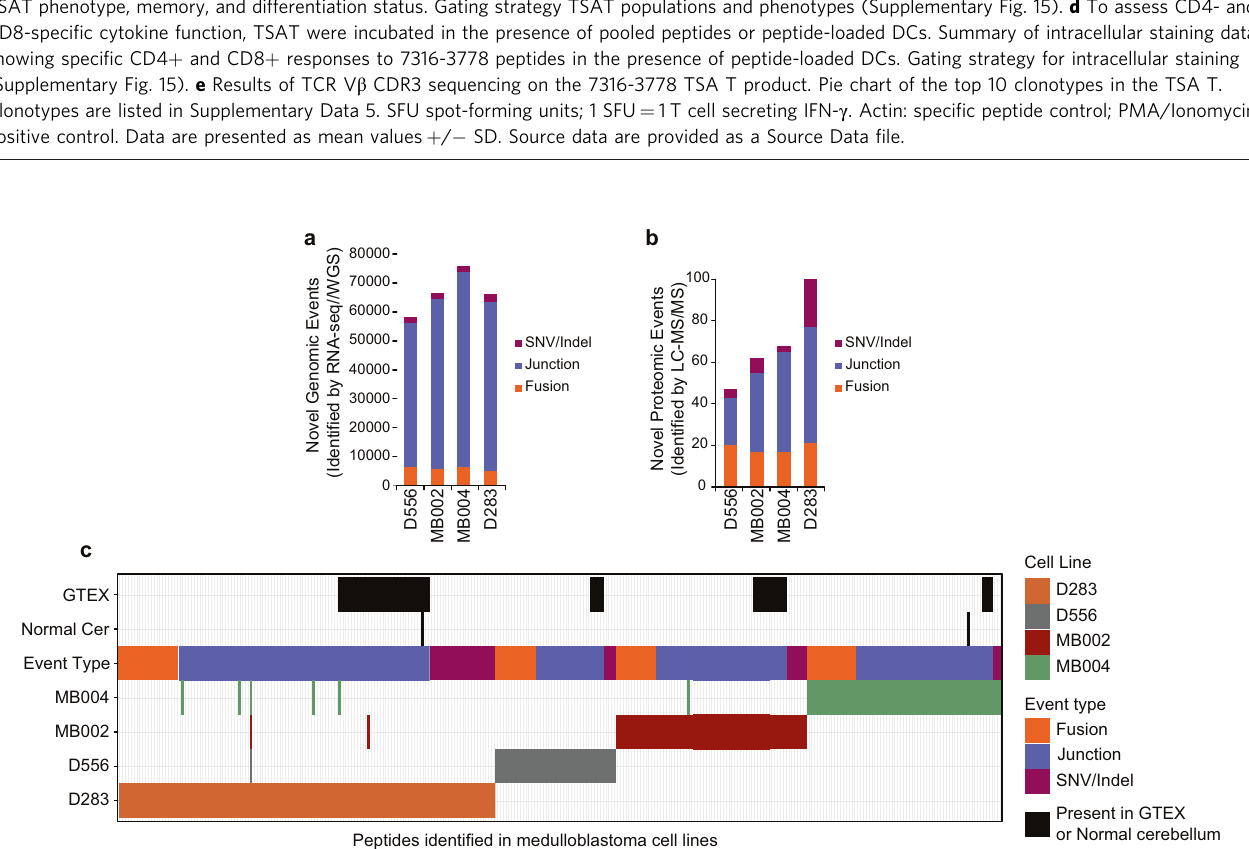
Fig. 4 Tumor-speci fi c genomic and proteomic events in medulloblastoma cells lines. The number of a genomic (detected by RNA-seq/WGS) and b proteomic (detected by LC-MS/MS) tumor-speci fi c events are shown for D556, MB002, MB004, and D283 medulloblastoma cell lines. The type of tumor-speci fi c genomic events is indicated: SNV/indels (purple), junctions (blue), and gene fusions (orange). c Tile plot depicting the number of tumor- speci fi c peptides identi fi ed in medulloblastoma cell lines. Black tiles indicate unannotated peptides identi fi ed in healthy cerebellum or normal tissues from GTEX. SNVs, fusions, and junctions are shown in green, red, and blue respectively. Source data are provided as a Source Data fi (GTEx) project (Supplementary Data 1 and Fig. 4c). We identi fi ed a total of 269 unique tumor-speci fi c peptides across the four MB cell lines — 47, 62, 68, and 100 peptides in the D556, MB002, MB004, and D283 lines, respectively (Supplementary Data 7). The